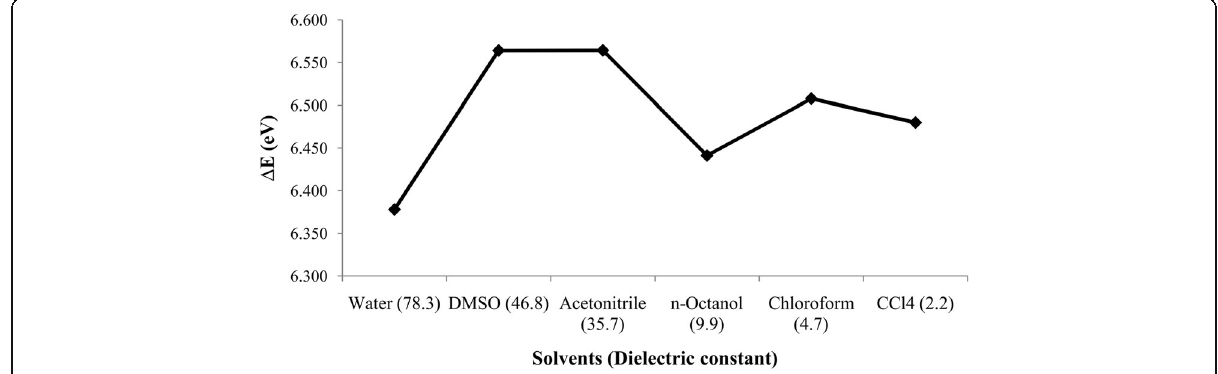
Fig. 11 Effect of solvent polarity on HOMO-LUMO energy gap of betulinic